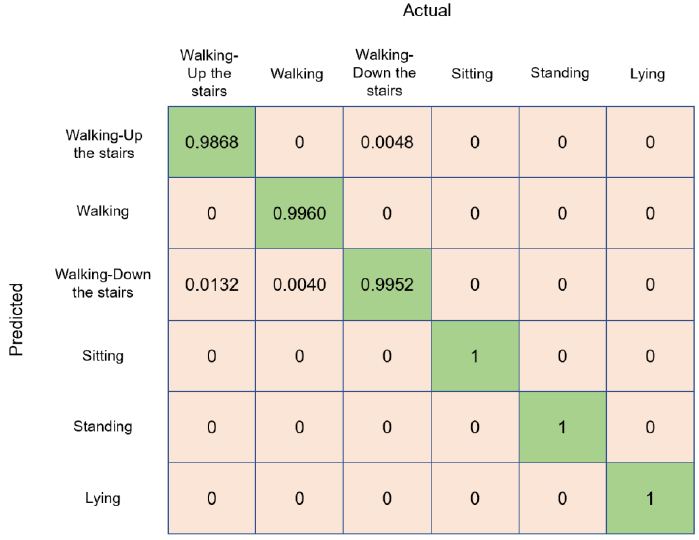
Figure 9. Normalized confusion matrix of the SVSL method.